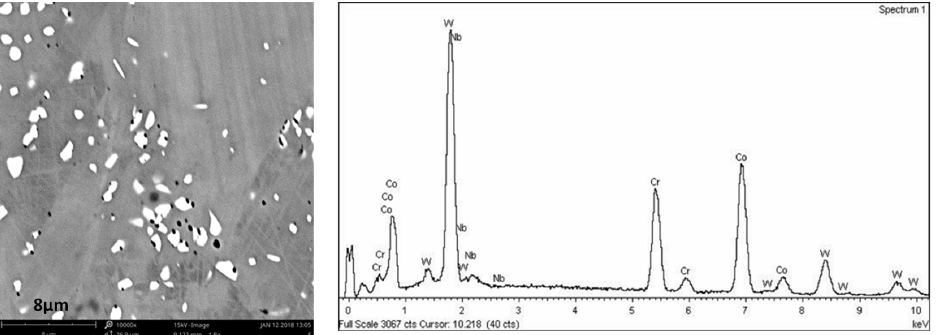
Figure 13. Microstructure of laser-sintered samples with white precipitates and EDS microanalysis of these precipitates.